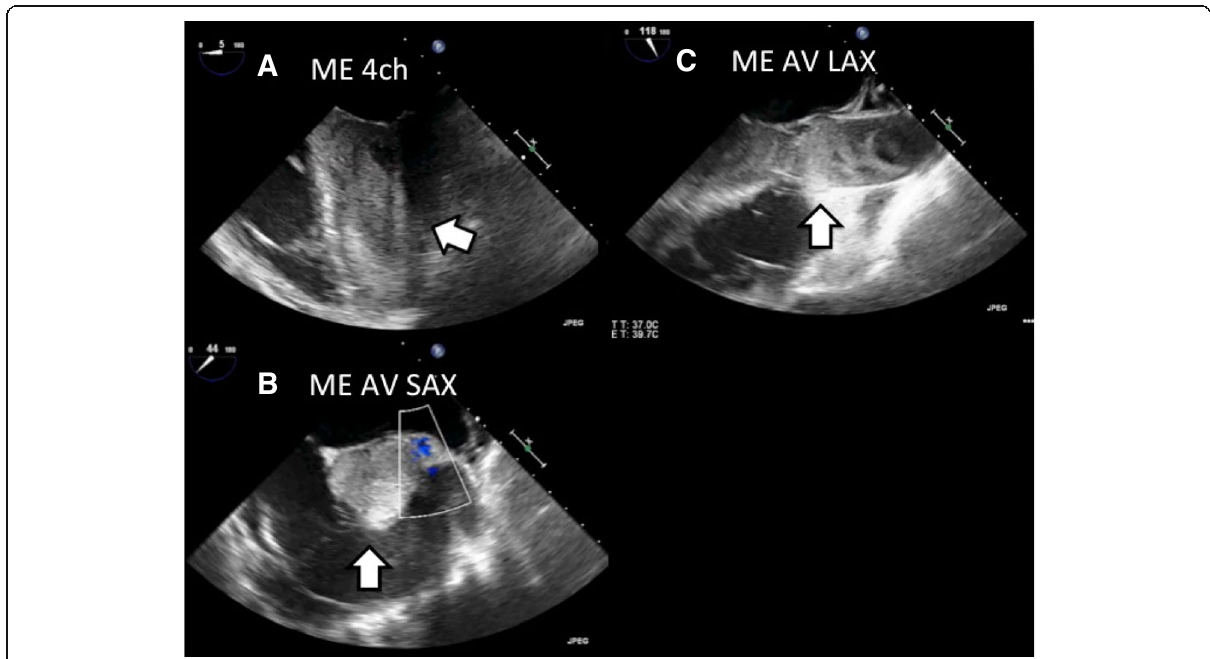
Fig. 5 Transesophageal echocardiography (TEE) after the onset of atrioventricular block. a Mid-esophageal 4-chamber (ME 4ch) view showed thrombus formations and congestion in the left ventricle. b Mid-esophageal aortic valve short-axis (ME AV SAX) view showed thrombus formations in the Valsalva sinus and aortic valve closure. c Mid-esophageal long-axis (ME AV LAX) view showed thrombus formations in the left ventricular tract and the Valsalva